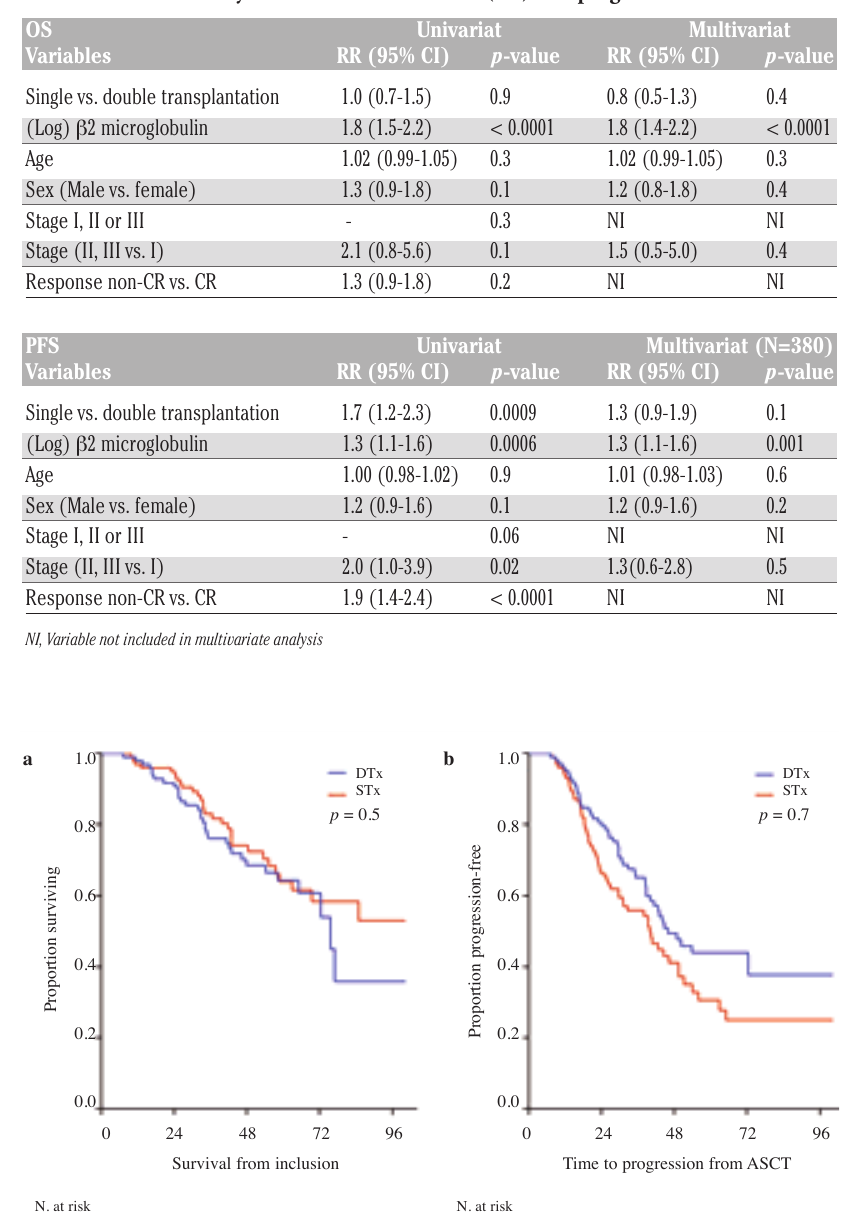
Table 3. Statistical analysis of variables on overall (OS) and progression free survival.